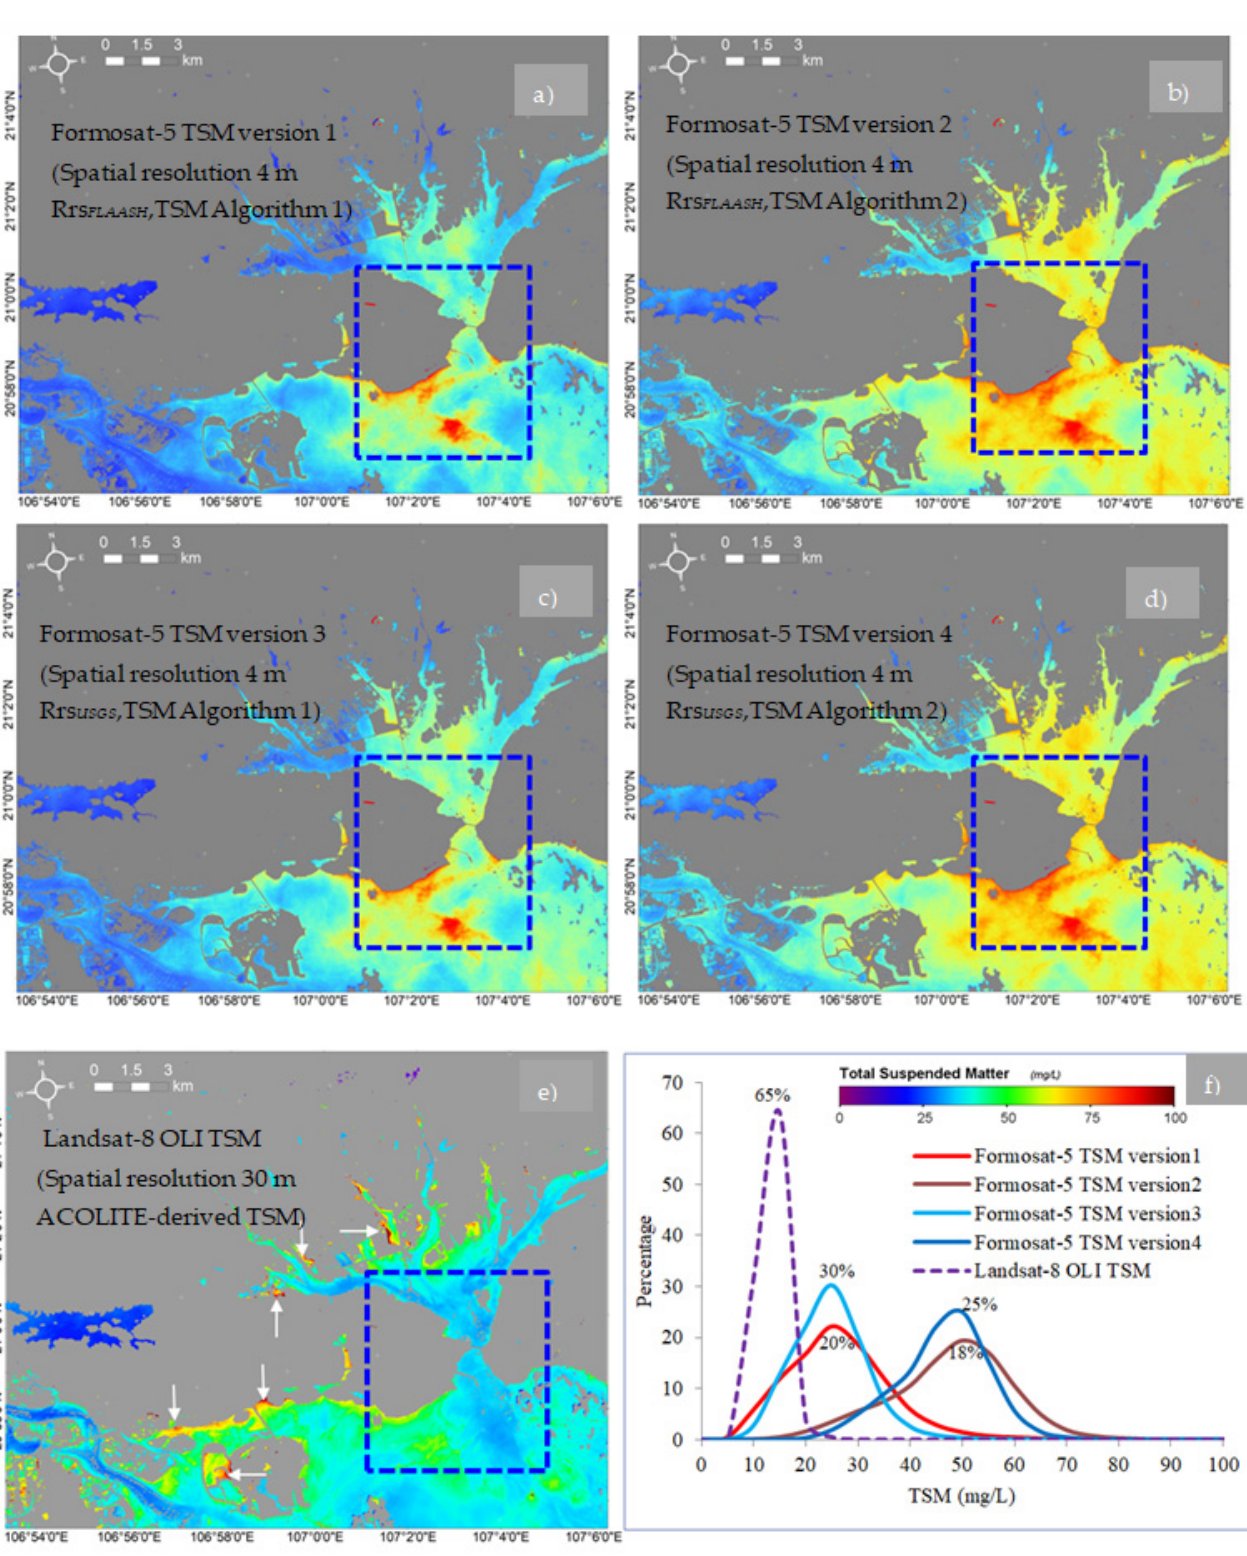
Figure 6. Comparison of TSM images derived from FS5 and Landsat-8 OLI; ( a ) FS5-derived TSM version 1; ( b ) FS5-derived TSM version 2; ( c ) FS5-derived TSM version 3; ( d ) FS5-derived TSM version 4; ( e ) Landsat-8 OLI-derived TSM; and ( f ) histograms. The color bar in Figure 6f explain TSM concentration for Figure 6a–e.